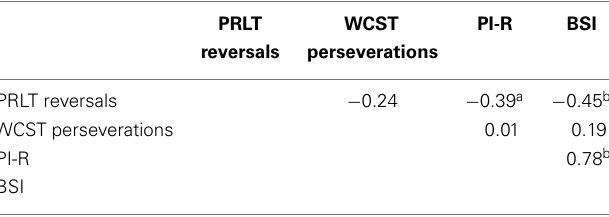
Table 5 | Correlations between several variables in the total group (GD and control)